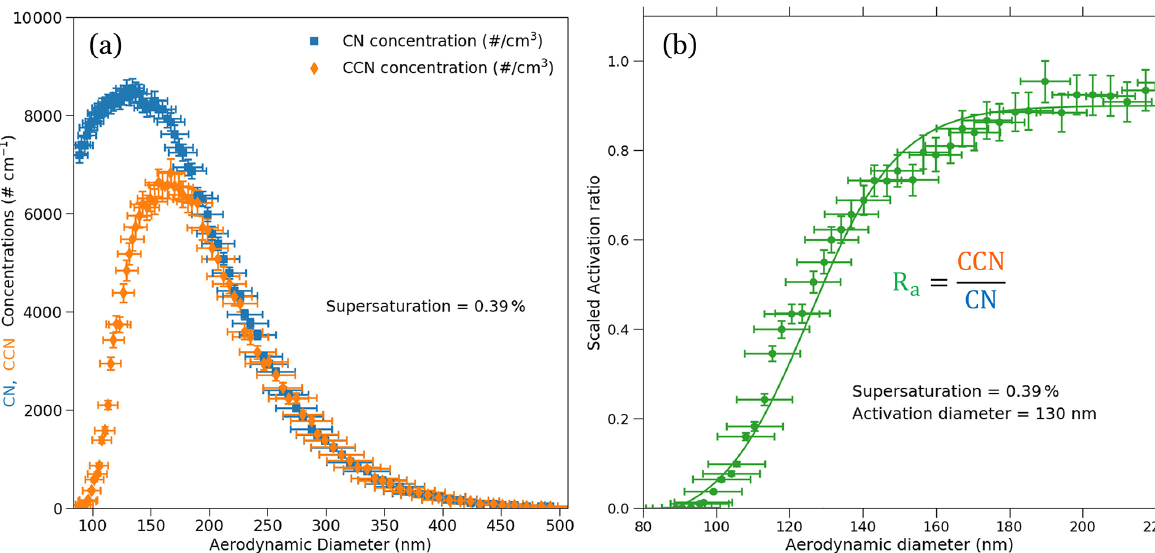
Figure 4. The CN and CCN number size distributions (a) and the corresponding size-resolved activation ratio (b) for sucrose are shown. The measurements were performed at a supersaturation of 0.39%. The activation aerodynamic diameter was found to be about 130nm from the activation ratio obtained using the size-resolved measurements. The dry aerodynamic activation diameter corresponds to the 50% activation efficiency, which corresponds to an activation ratio of 0.47. Furthermore, the uncertainties in the aerodynamic diameters, CN and CCN number concentrations, and size-resolved activation ratio are also denoted on the plot using their respective error bars. Table 1. The table provides the analysis summary of the set of measurements performed for sucrose with the help of the AAC–CCNC setup. At low supersaturations, sucrose has large dry activation diameters for which the measurement uncertainties are slightly lower. Furthermore, the CCN activity predictions in terms of κ using the Köhler theory are also accurate. With an increase in the supersaturation the dry activation diameter reduces, and correspondingly the variations in κ continue to rise, being as high as about 35% at 0.58% instrument supersaturation. The conversion of dry aerodynamic activation diameters of sucrose to their corresponding volume equivalent diameters was done with the help of the dynamic shape factor. The shape factor measurements and analysis were performed following the procedure described in Tavakoli and Olfert